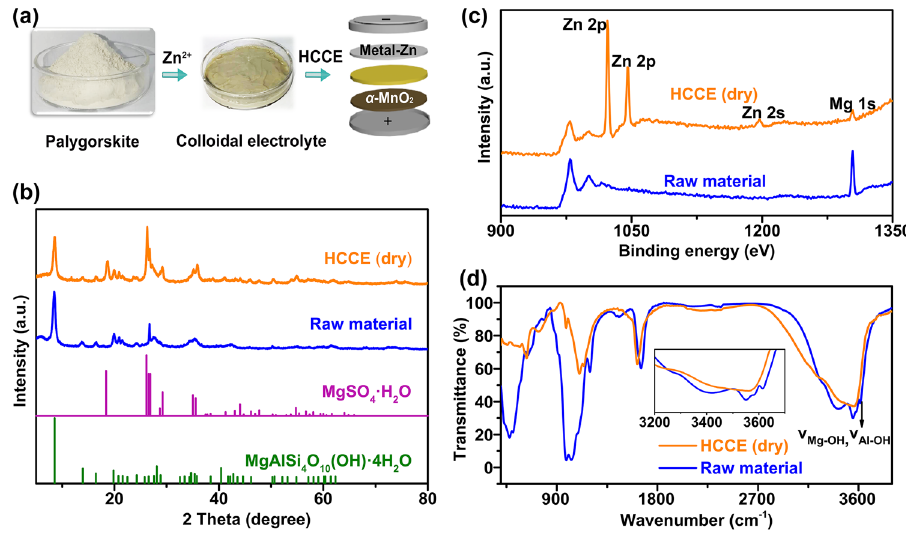
Fig. 1 a A simple process of colloidal electrolyte preparation and application. b XRD patterns of raw material (palygorskite) and colloidal elec- trolyte (after drying). c XPS full-spectrum image of raw material (palygorskite) and colloidal electrolyte (after drying). d FTIR spectra of raw material (palygorskite) and colloidal electrolyte (after